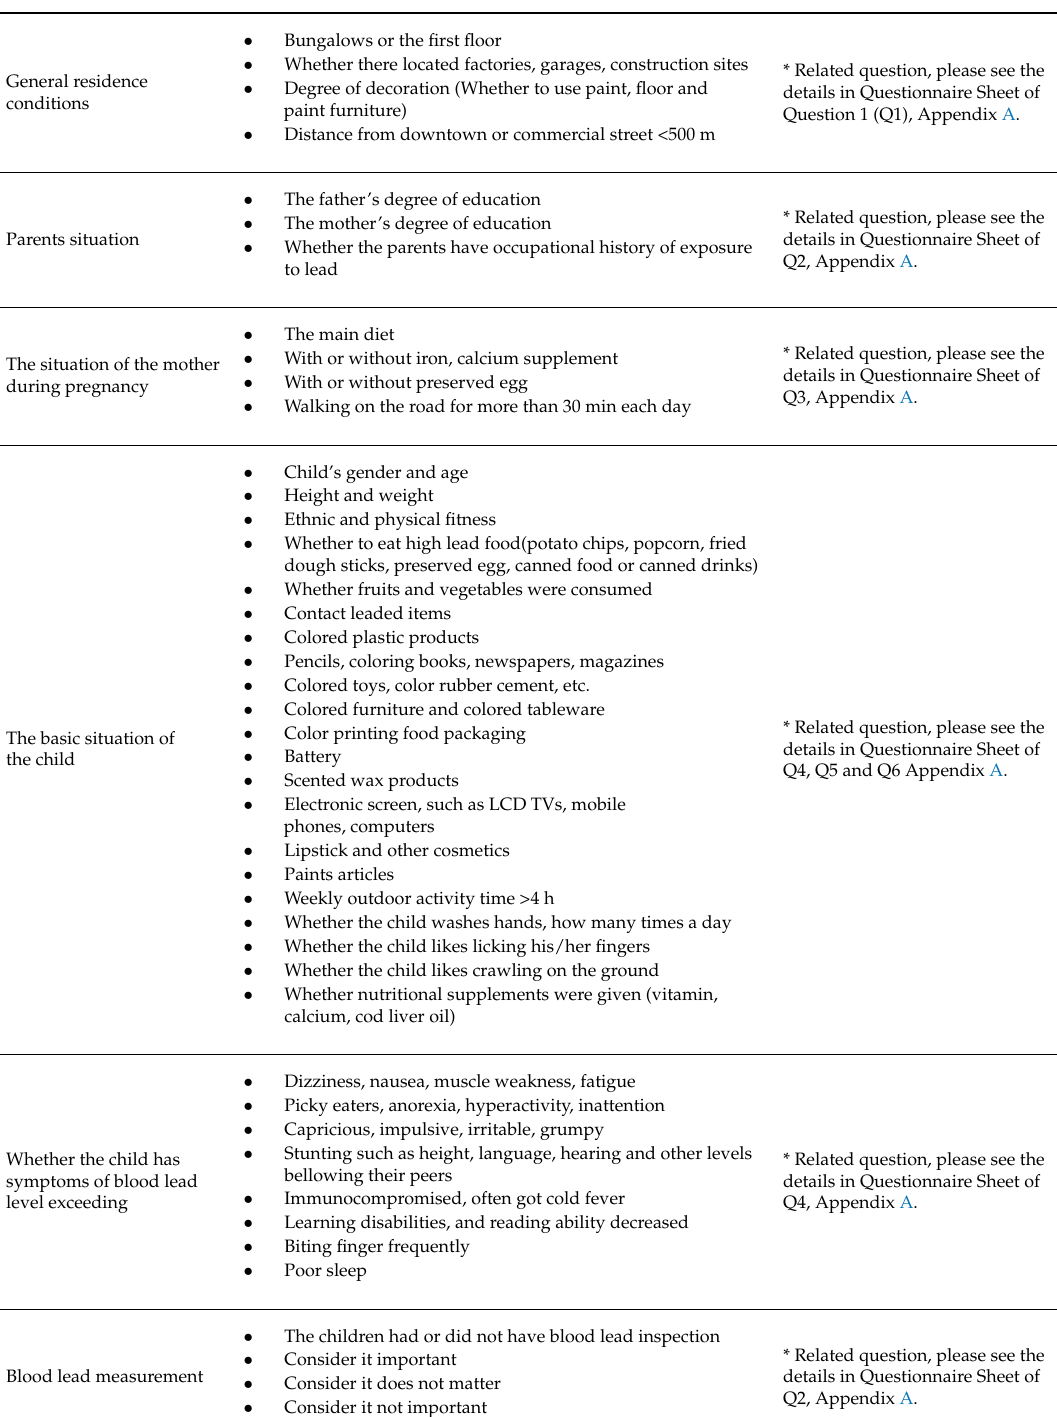
Table 1. Lead exposure sources and behaviors of children in 4 Northwestern Valley Cities,